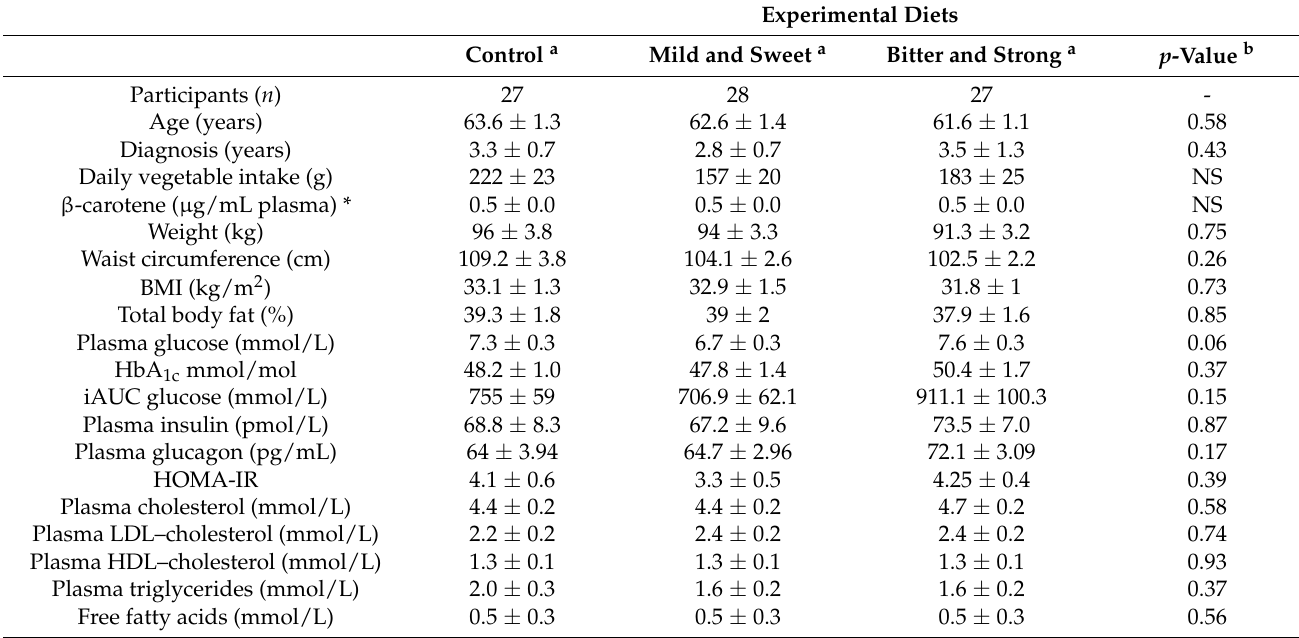
Table 2. Clinical baseline characteristics of the subjects in the three intervention